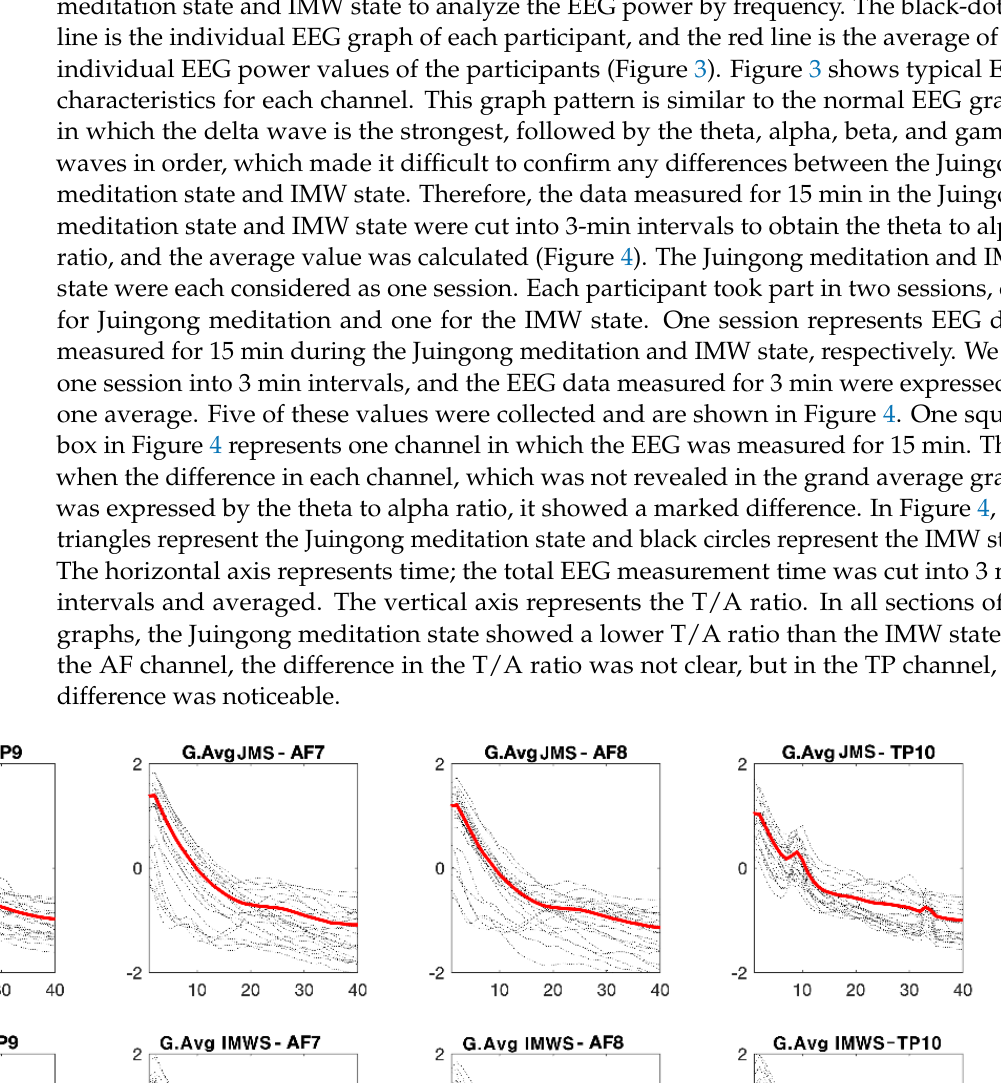
Figure 4. Within-session theta/alpha ratios by period. TP: Temporoparietal, AF: Anterior frontal, △ : Juingong meditation, ○ : IMW. The horizontal axis represents time, and the vertical axis represents the theta/alpha ratio. The total experimental time was 15 min, averaged for 3 min intervals, and displayed as a graph. The theta/alpha ratio is a value obtained by calculating the theta power and alpha power in each channel, and then using them as the numerator and denominator, respectively. In all areas, the theta/alpha ratio was lower in the Juingong meditation than in the IMW. The differ- ence is particularly noticeable in the TP channels. The difference in the TP channel was evident from periods 1 to 5. In this study, since the initial 5 min was taken as the time required to reach the concentration state, it was expected that the difference between the Juingong meditation state and IMW state would not be apparent at the beginning of the experiment. However, in the TP channel for the Juingong meditation state and IMW state, it was confirmed that the T/A ratio was con- stantly different from the beginning of the measurement to the end. The data for the first 5 min were discarded and the T/A ratio was calculated from the data for the second 10 min, as shown in Figure 5. The results of the paired t-test are shown in Table 1. As a result of the normality test for the T/A ratio data, the normality assumption was satisfied in the